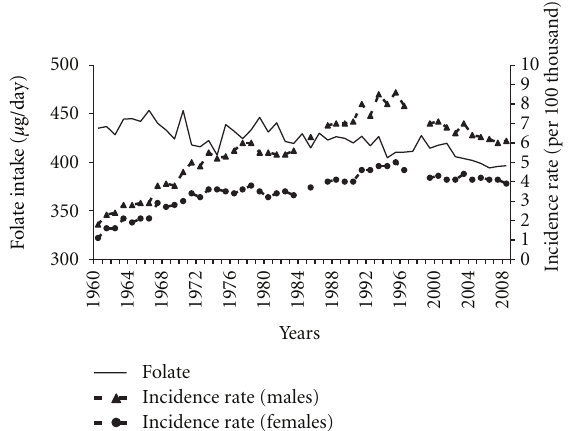
Figure 11: Folate intake and pancreatic cancer morbidity 1960– 2008.